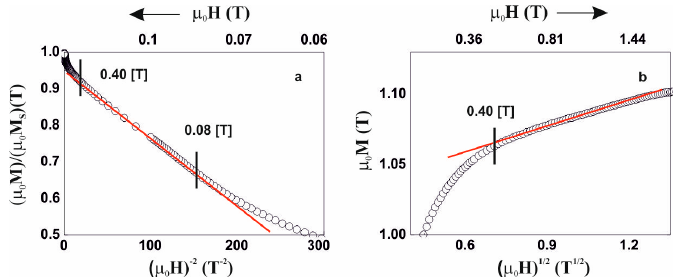
Figure 7. Magnetisation for the alloy Fe 39 Co 33 Y 8 B 20, as a function of: ( a ) (µ 0 H) − 2 , ( b ) (µ 0 H) 1/2 .